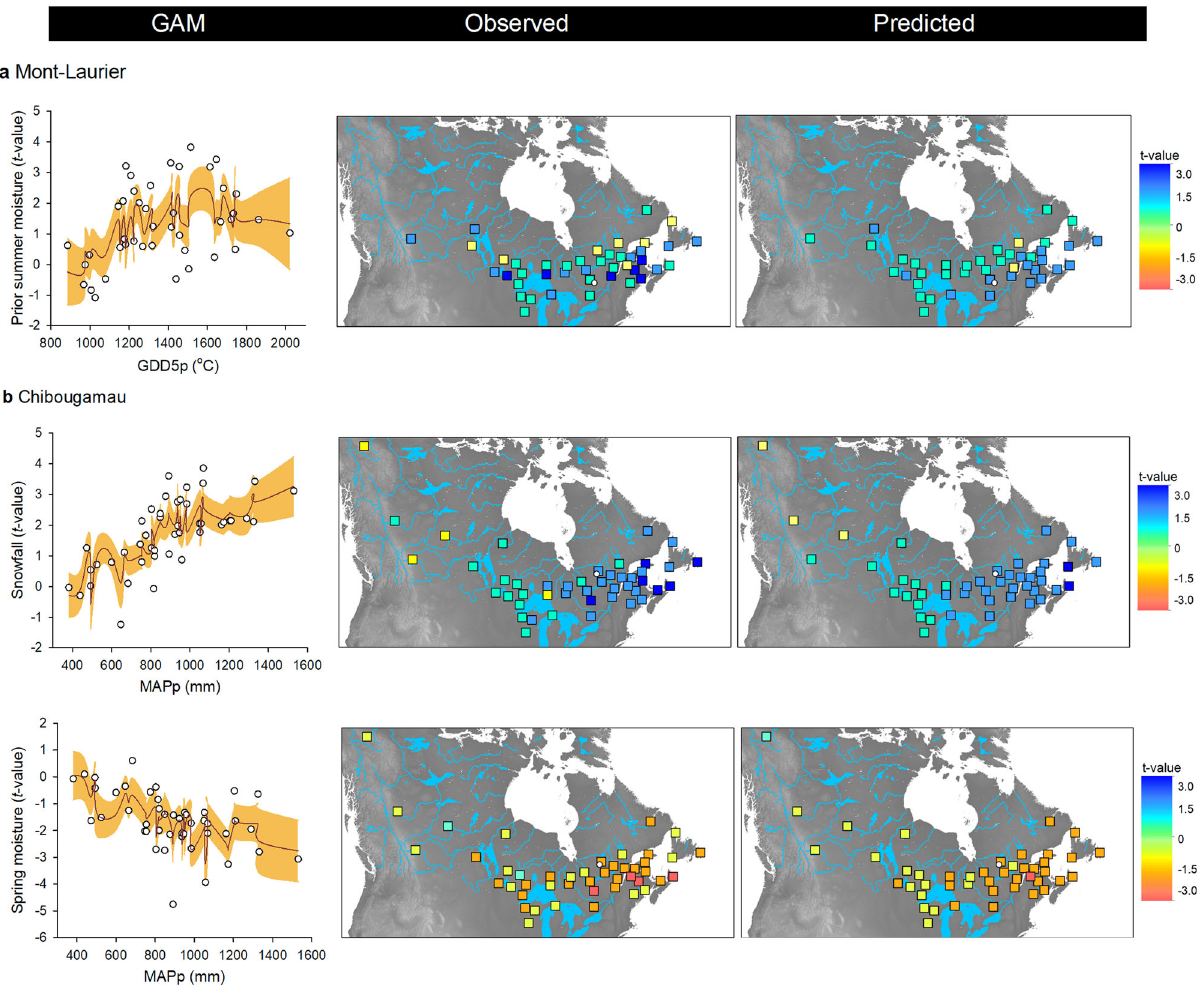
Fig. 7 Relationships between climate sensitivity traits and phenotypic GDD5p and MAPp clines. CStraits are the t -value scores obtained from GAMM linking NPP and climatic fl uctuations for the a Mont-Laurier and b Chibougamau sites (see Fig. 3). Shown is the CStrait for summer moisture during the year preceding ring formation, snowfall, and spring moisture for the current year ring formation. The farther from zero is the t -score value, the stronger is the relationship between NPP and the targeted climate variable. Biplots at left illustrate observations (white dots) along with generalized additive model (GAM) predictions (red lines), with two-sided 95% con fi dence intervals (orange shadings). Maps at right illustrate the variability of CStraits in coordinate